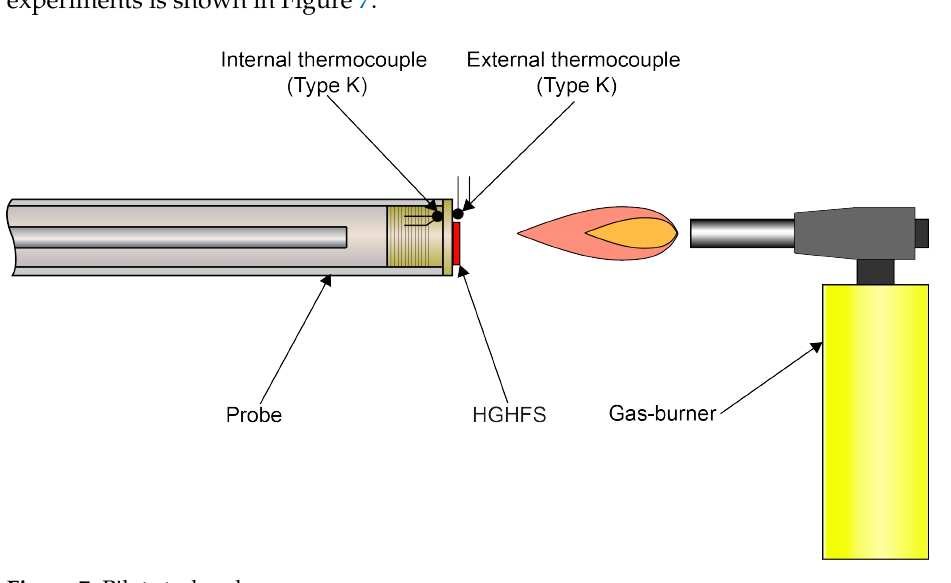
Figure 7. Pilot study